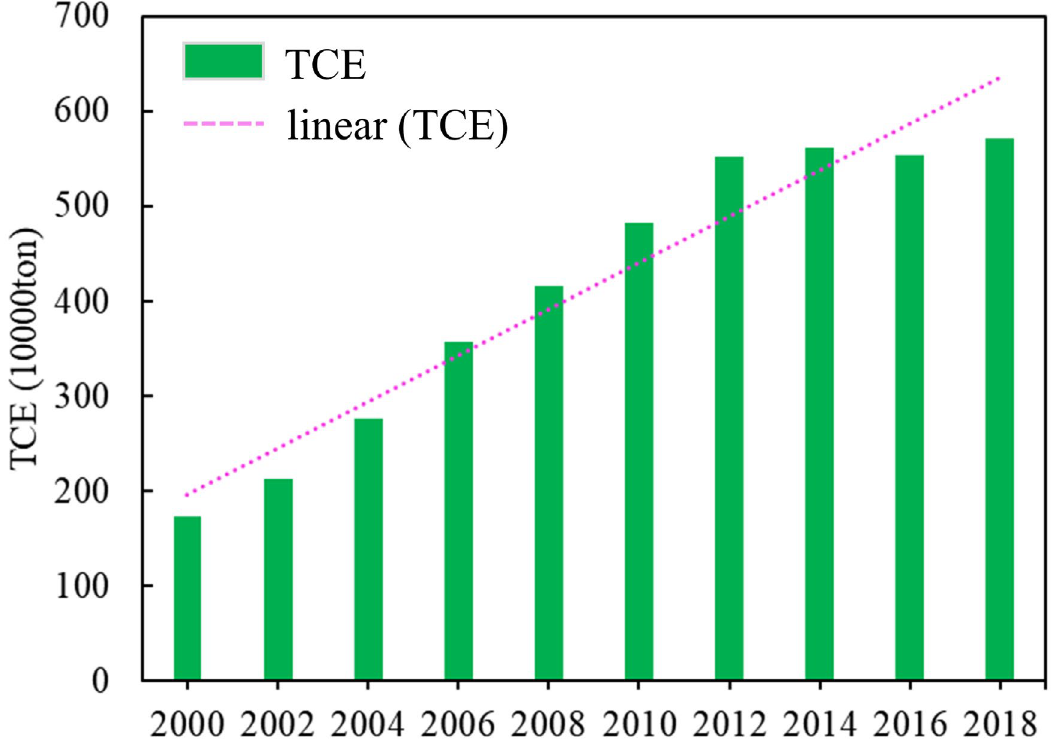
Figure 3. Changes in TCE of CUA from 2000 to 2018.